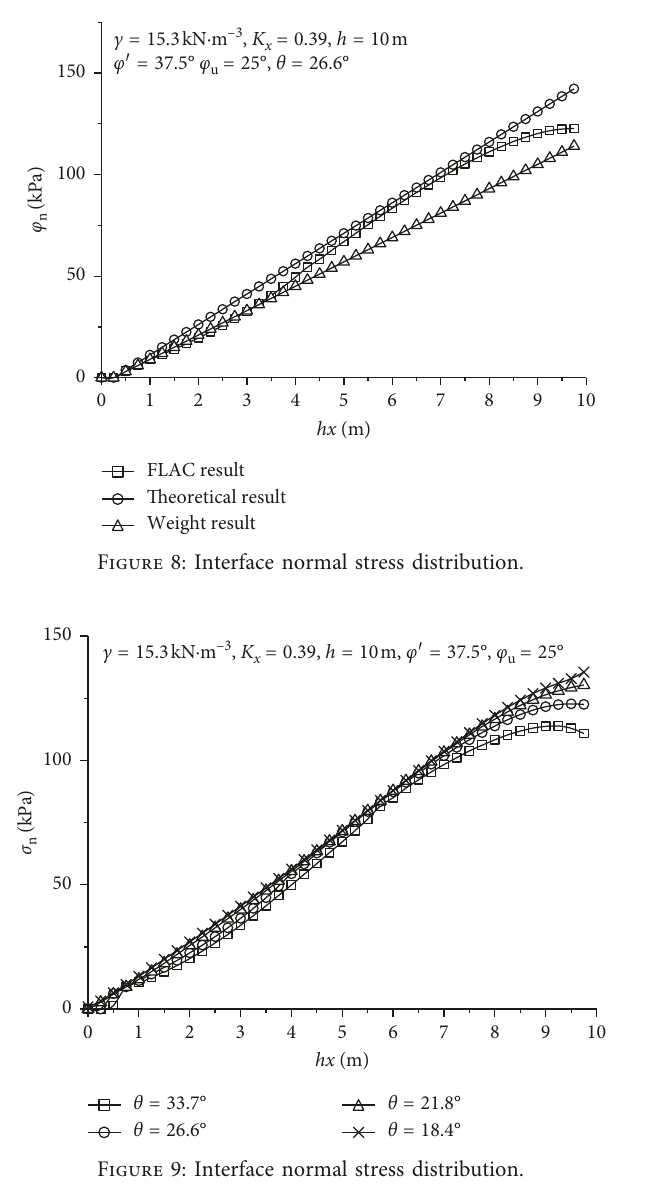
Figure 9: Interface normal stress distribution.